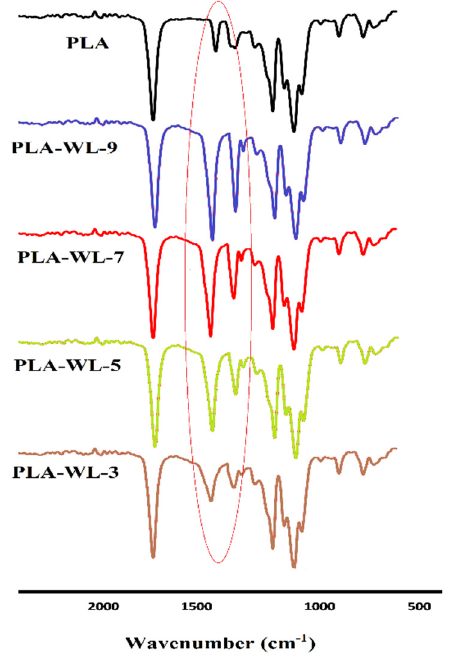
Figure 2. FTIR spectra of PLA and PLA-WL biocomposites. Table 2. The mechanical characteristics of the fabricated PLA-WL